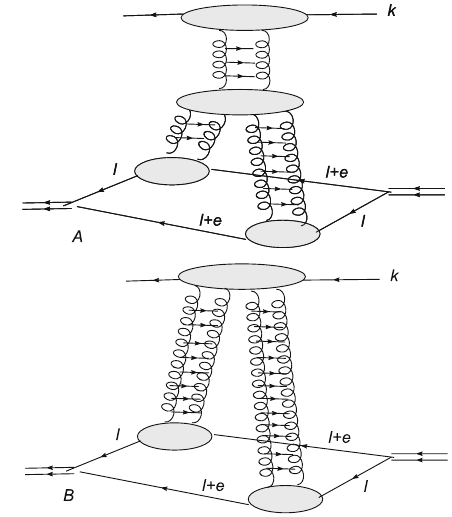
Fig. 8 High-mass diffraction ( a ) and double pomeron exchange ( b ) omitted up to now. So we have to add the double pomeron exchange (DP) contribution. Unlike our previous calcula- tions for this contribution energy ( k − q 1 − q 2 ) 2 = ( k − e ) 2